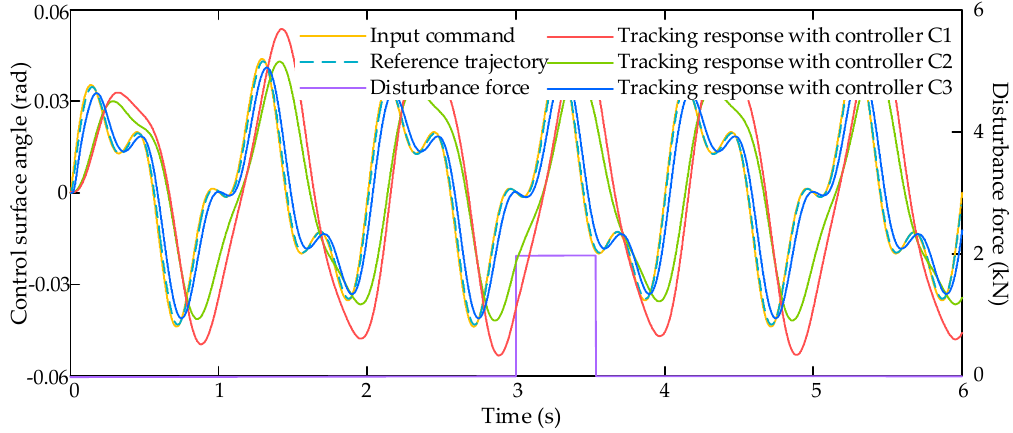
Figure 6. Tracking responses with dynamic signal input command. Sensors 2017 , 17 , 2444